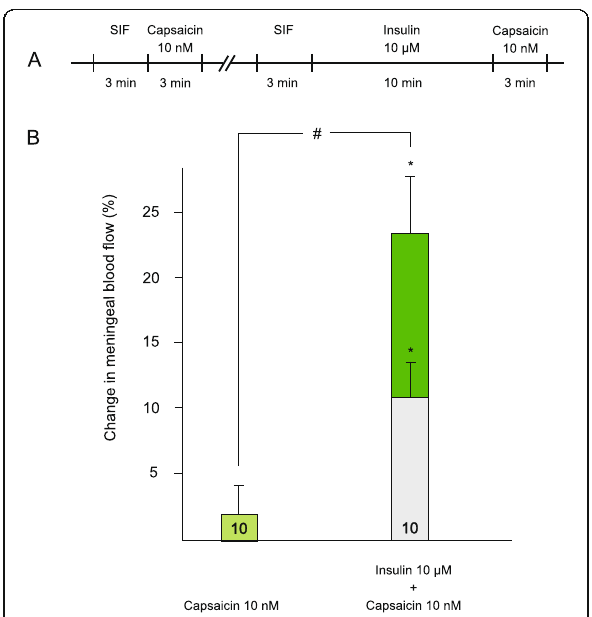
Fig. 3 Changes in meningeal blood flow induced by topical application of capsaicin at low concentration. ( A ) Flowchart summarizing the experimental protocol. ( B ) Blood flow increasing effect of capsaicin (10 nM for 3 min) before and after insulin (10 μ M for 10 min) applied topically to the dura mater. The light grey bar indicates the effect of insulin application alone, coloured bars indicate the capsaicin-induced changes in blood flow. The number of measurements is indicated in the bars. *: statistically different from the basal flow. #: statistically different from the effect without pretreatment